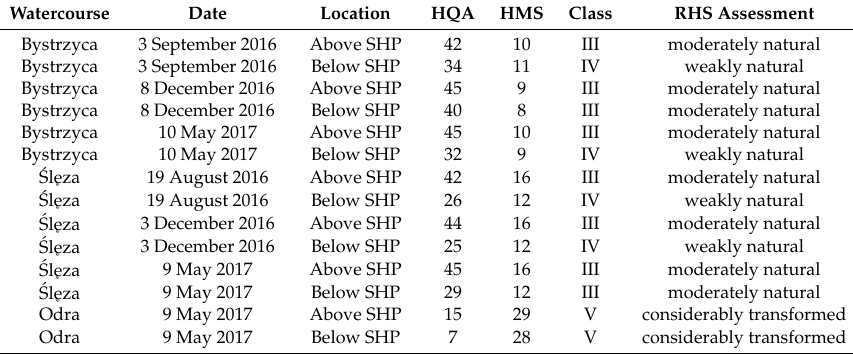
Table 5. Assessment of the hydromorphological status based on the calculated values of HQA and HMS over the research